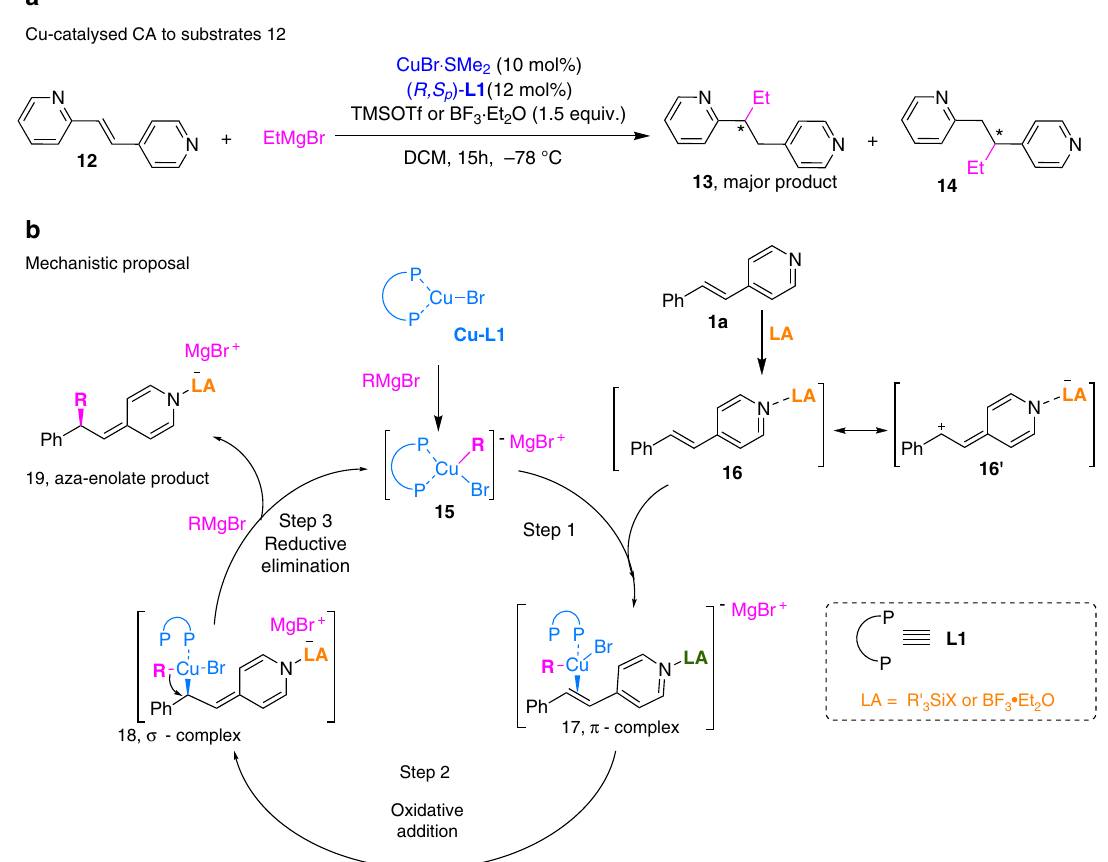
Fig. 3 Cu-catalysed CA to substrates 12 and proposed catalytic cycle. a These experiments clarify the difference in reactivity between 4-substituted and 2- substituted pyridines. b Proposed tentative catalytic cycle for LA promoted Cu-catalysed CA of Grignard reagents to alkenyl pyridines